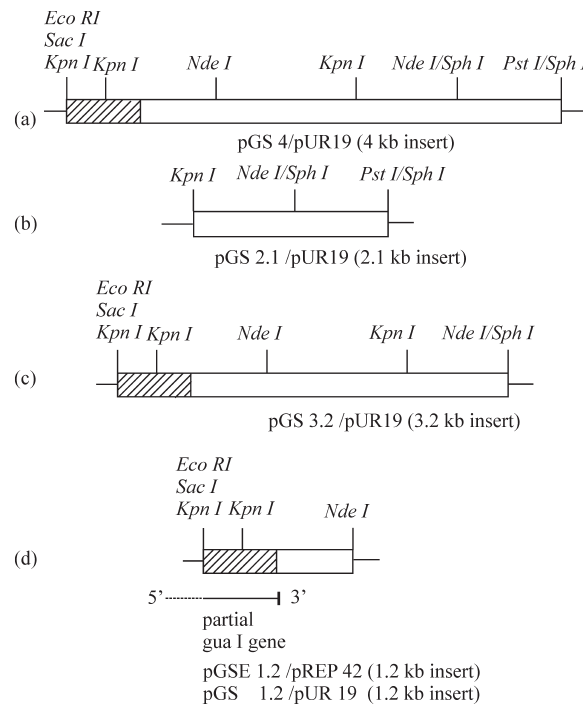
Figure 1 - The cloned 4kb Schizosaccharomyces pombe fragment in plasmid pUR19 containing a partial gua1 gene (a) and three subclones (b-d).SubclonepGS1.2containedtheshortest(1.2kb)DNAfragmentthat complements the gua1 mutant. The position and orientation of the partial gua1 gene is represented by the hatched box and